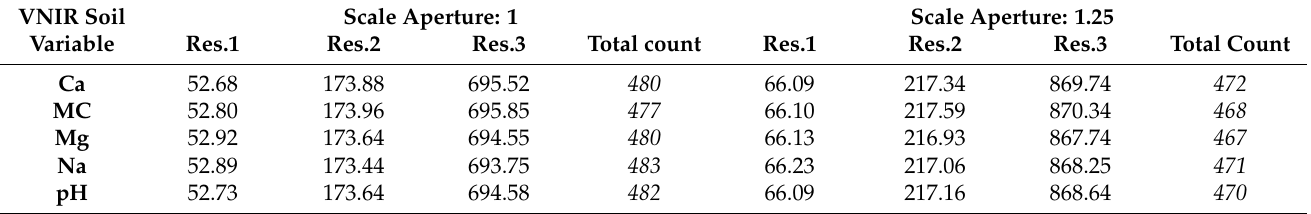
Table 4. Distribution of 3-resolution bisquare basis functions according to scale aperture.